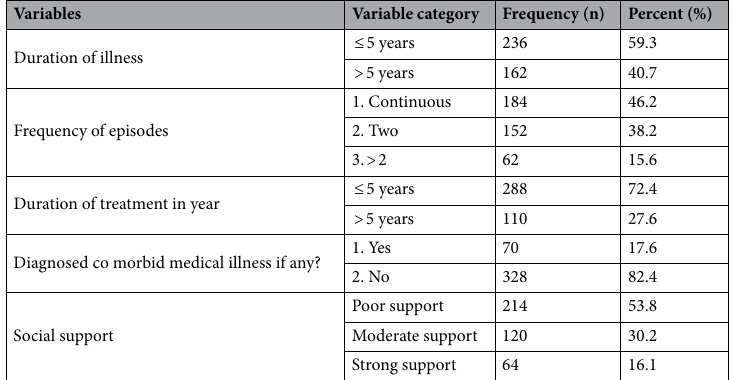
Table 3. Clinical factors about the patient and social support related factors among caregivers of patients with mental illness at DRH, Ethiopia, 2020 (n = 398).